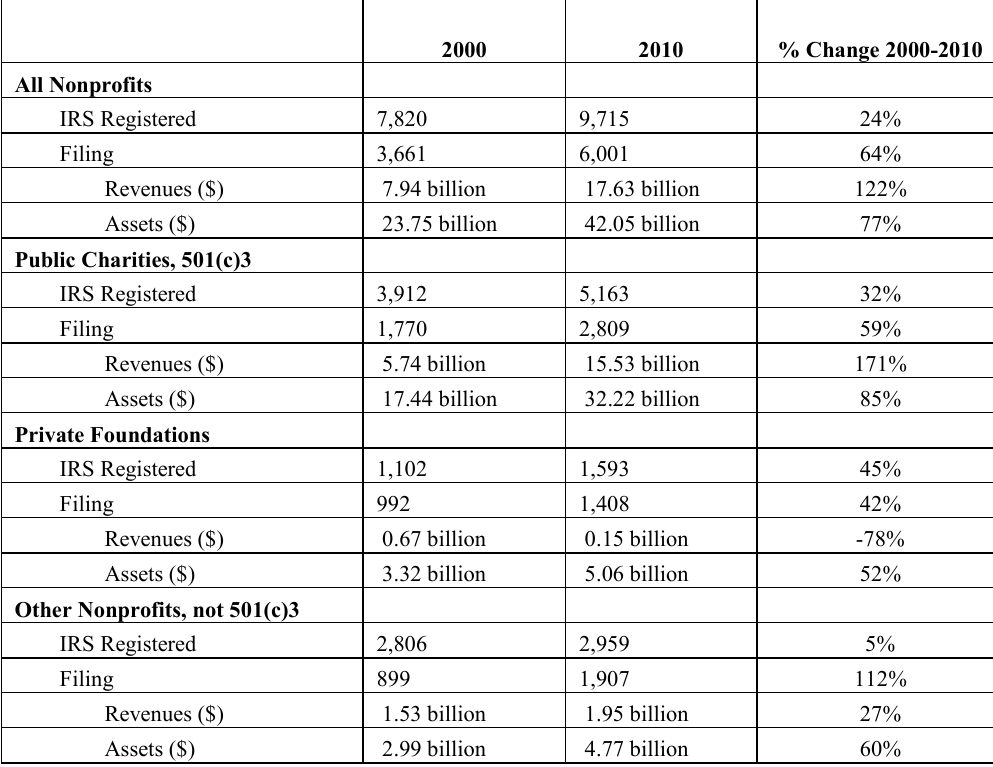
Table 2. Cuyahoga County Nonprofit Organizations, Size and Financial Activity,